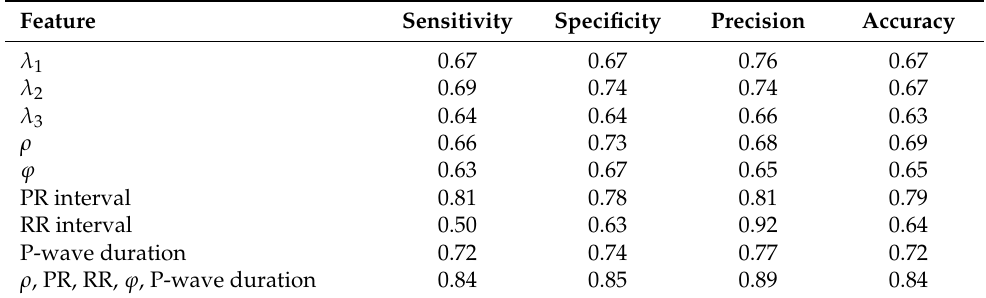
Table 4. Classification results when differentiating pre- and post-PVI using the different features, and the combination that maximizes global